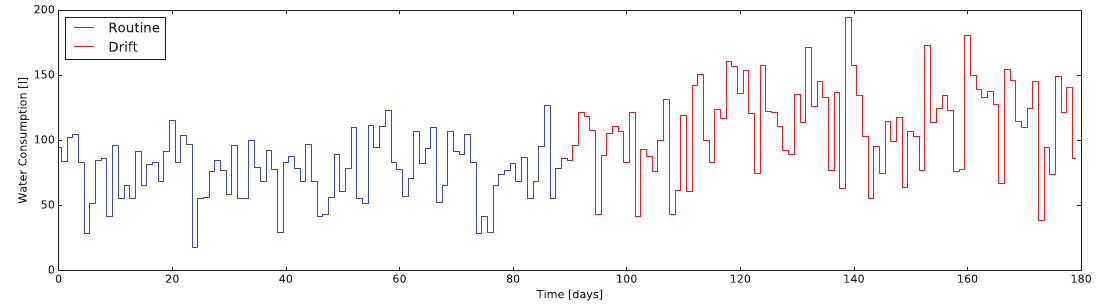
Figure 2. Resource Consuming (RC) indicator: water consumption computed over the whole